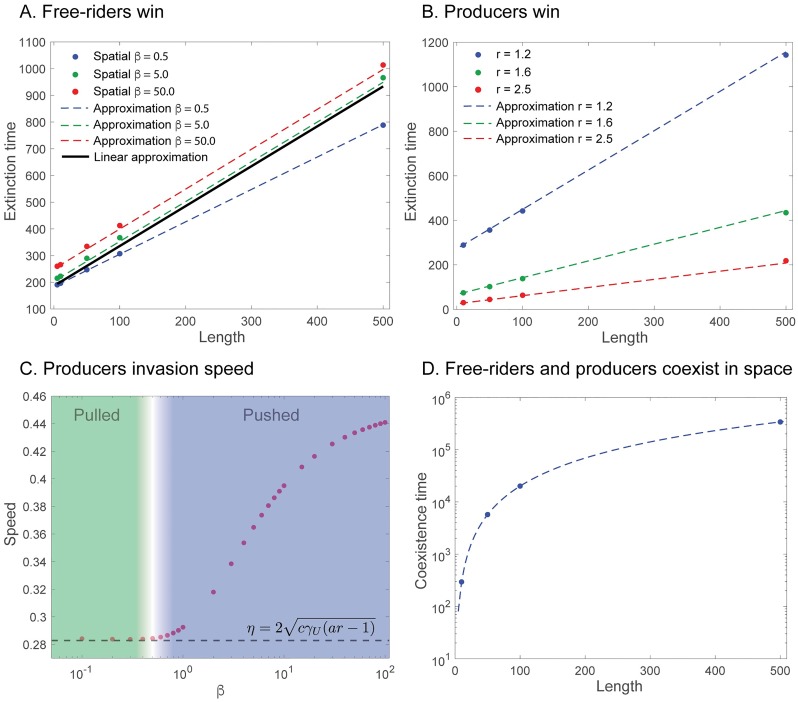
Extinction times increase linearly with length, and coexistence times increase quadratically with length.A: Producer extinction time vs. length of the domain. theoretical lines were obtained using Eq (20) (black, blue), and the red and green lines were obtained using the actual time of the slow manifold from the well-mixed model Eqs ((8)–(10)), with the wave front speed in Eq (19). Parameters used: a = 0.9, c = 0.5, σ = 2.0, r = 0.9, γU = γV = 0.5, ϵ = 2 × 10−3. B: free-rider extinction time vs. length of the domain. theoretical lines were obtained using Eq (22). Parameters used: a = 0.9, c = 0.5, σ = 2, β = 0.5, γU = γV = 0.5, ϵ = 2 × 10−3. C: Analysis of the transition from pulled to pushed fronts. This was only observed when the producer invades. As β increases, we shift from the pulled velocity predicted by linear theory. The transition occurs in the colorless zone. Parameters used: a = 0.9, c = 0.5, r = 1.2, σ = 2, γU = γV = 0.5, ϵ = 2 × 10−3. D: Time to reach coexistence state or time to slow manifold with c = 0. Dashed line obtained from Eq. (S43) (S1 Model Analysis). Parameters used: a = 0.9, σ = 2, β = 0.5, 5, 50, γU = γV = 0.5, ϵ = 2 × 10−3. The times to coexistence for different β values deviate by less than 0.1 cell cycles.